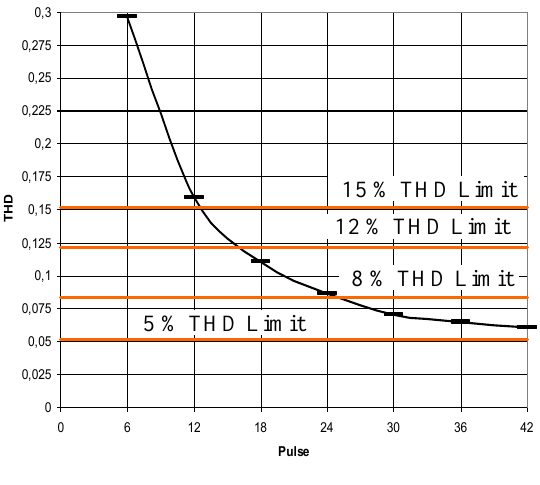
Fig. 8. Dependence of current THD on rectifier